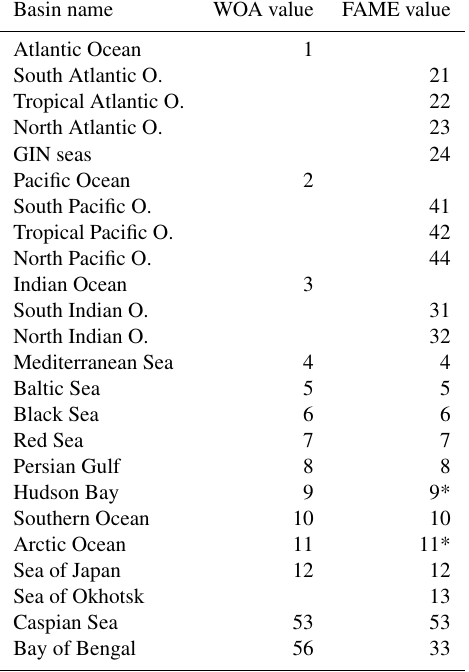
Table A2. Values obtained for the δ 18 O sw – salinity relationships. Basin name